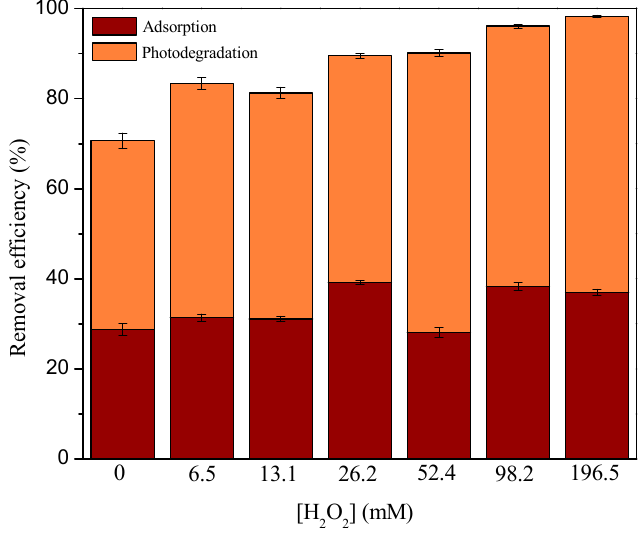
Figure 7. Contribution of adsorption and photodegradation under SSR (calculated after 60 min of processes) for MB removal efficiency ( c 0 = 2.45 · 10 − 2 mM) in the presence of 29 tablets of Fe 2 O 3 /TiO 2 /PVC composites and different H 2 O 2 concentrations at a stirring rate of 490 rpm.